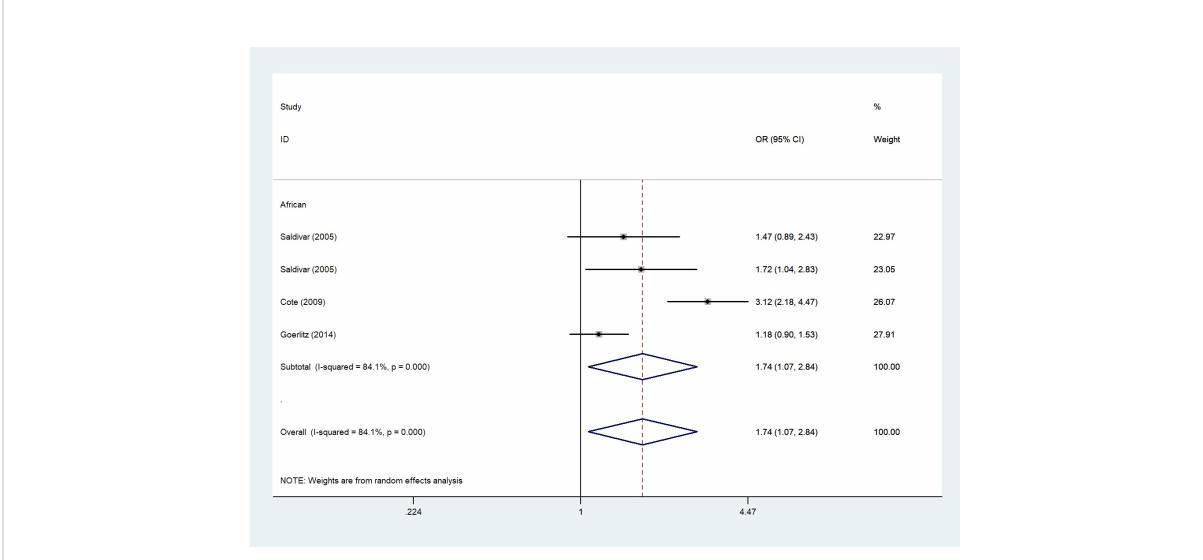
FIGURE 7 The relationship between cancer risk and the NQO1 gene rs1800566 polymorphism in Africans (C-allele vs. T-allele model). There were signi fi cantly increased association between NQO1 polymorphism in African individuals. The squares and horizontal lines correspond to the